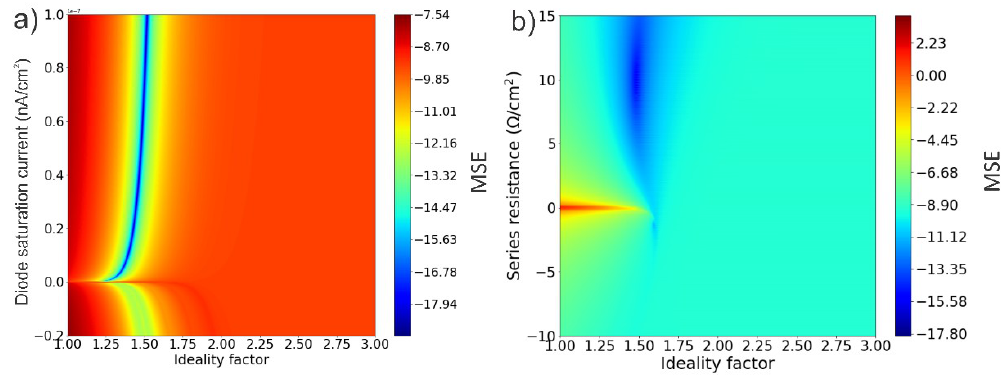
Figure 5. Mean Squared Error (MSE) behavior as function of the estimated parameters for cell 8. MSE as function of ideality factor and diode saturation current ( a ), and MSE as function of the ideality factor and series resistance ( b ).